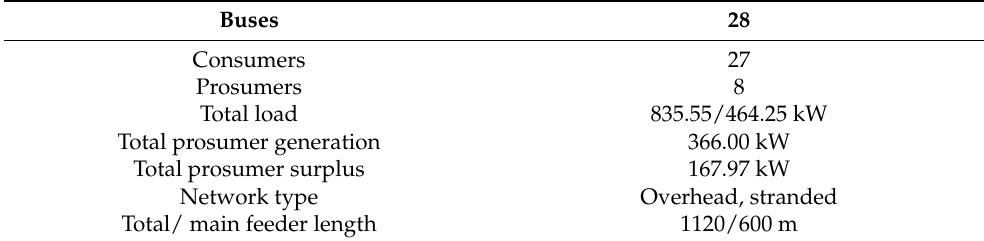
Figure 4. Network R28. Table 1. Summary data for network R28.